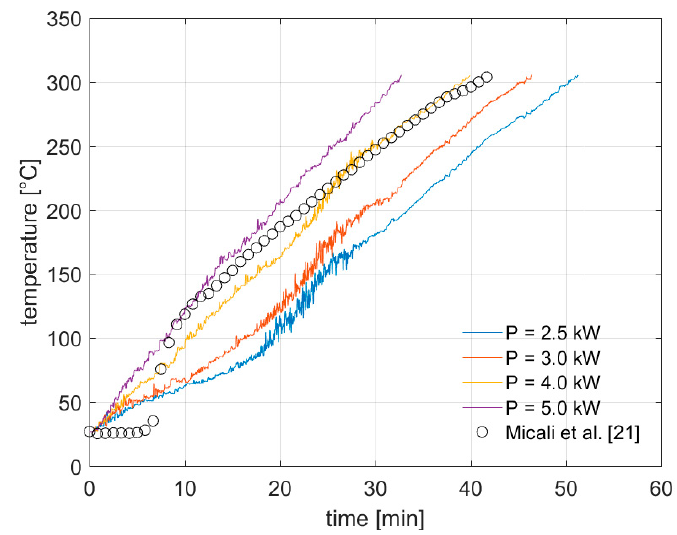
Figure 2. Average temperature in HTC reactor during heating process. The numerical results are compared with experimental measurements in [21].